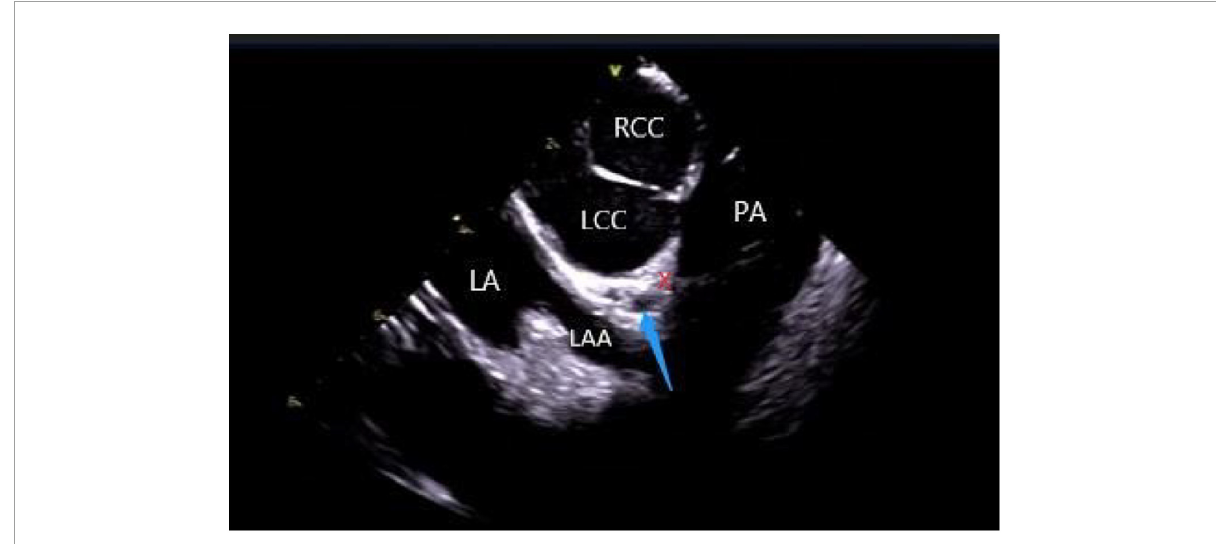
FIGURE6 ICE view of the aortic root and pulmonary artery at the left ventricular summit region, viewed from the right ventricular outflow tract. At the center, a short axe of the left main coronary artery (LMCA) (blue arrow) surrounded by a thick layer of adipose tissue (LVS). RCC, right coronary cusp; LCC, left coronary cusp; LA, left atrial; LAA, left atrial appendage; PA, pulmonary artery; The LVS is marked with an